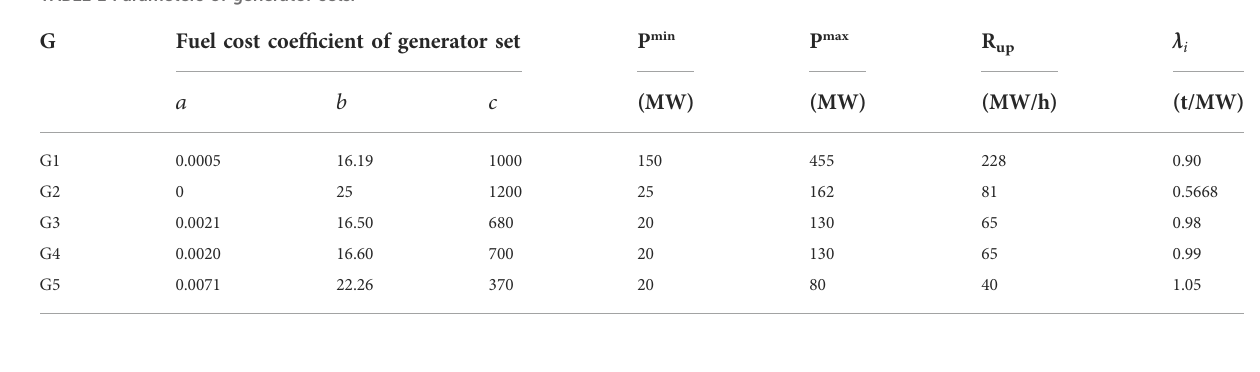
TABLE 1 Parameters of generator sets.